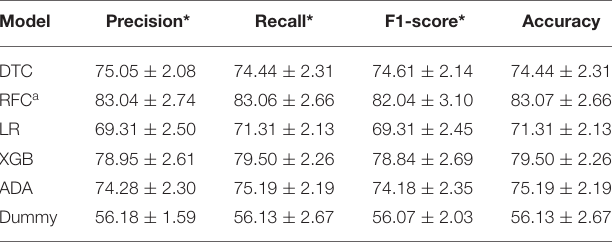
TABLE 3 | Accuracy of the machine learning models predicting Self-rated health (SRH).